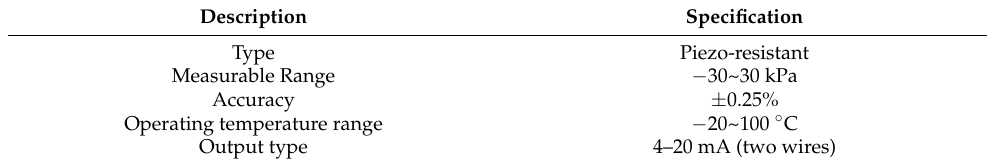
Figure 3. Schematic diagram of the thread socket and pressure transducer connected to the exhaust pipe. Table 2. Specifications of the pressure transducer used for back-pressure measurement.